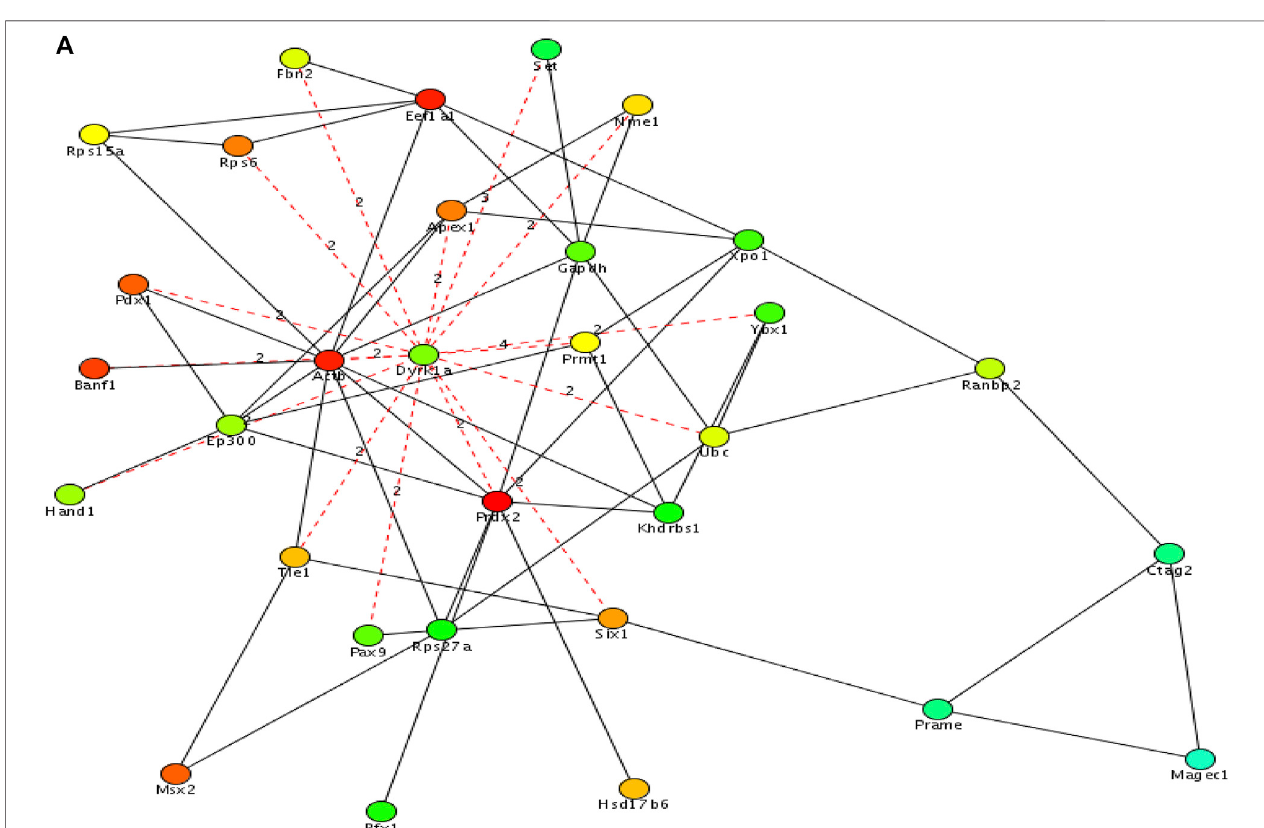
FIGURE 3 | (A) Ctag1b/a STRING network. ctag1b, ctag1a are aliases of ctag1b/a . The network neighborhood was reconstructed from fi rst and second level interactorsof ctag1b/a , pasd1 and ZIC3 aretranscriptionfactors. Pasd1 links the ctag1b/a group (lower groupcontainingthe mages,cage1 and others)